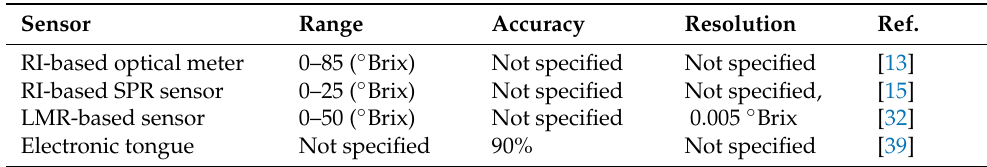
Table 3. Sample-based destructive Brix sensors reported in the